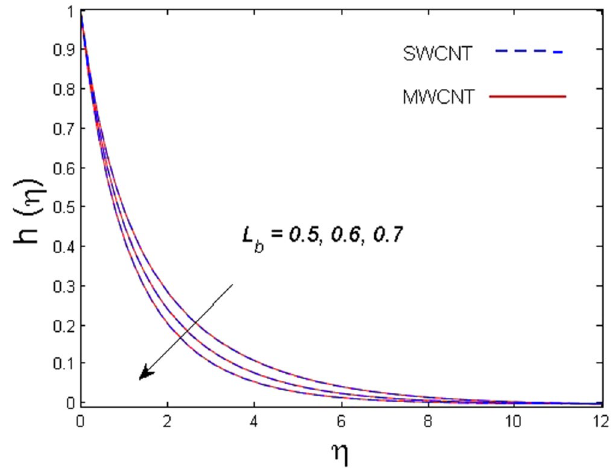
Figure 15. Outcome of L b on h ( ) η .